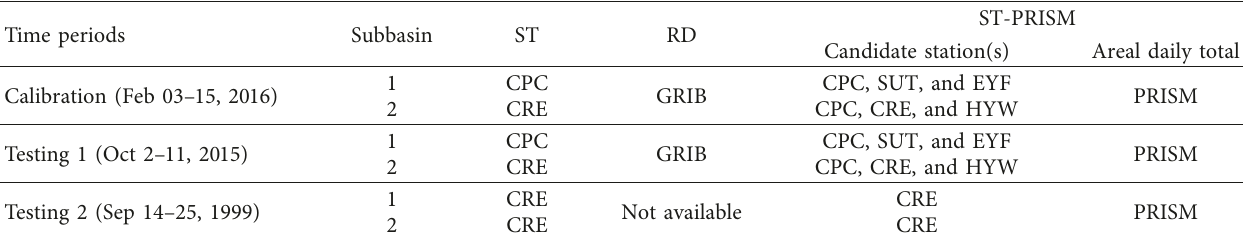
Table 3: Precipitation data source used for the flood simulation in the Waccamaw watershed. Time periods